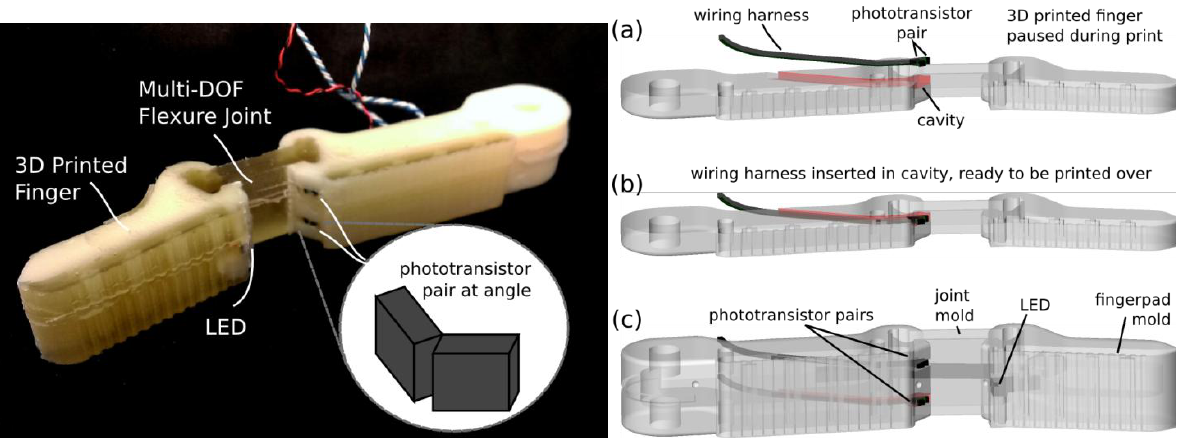
Figure 1. Joint-angle sensor design. An infrared LED shines across the joint onto two angled pairs of phototransistors ( left ). An embedded fused-deposition manufacturing method is used to integrate sensing into the finger design ( right ): (a) print is paused; (b) wired sensor is inserted into cavity designed to hold it; (c) whole assembly is printed over.